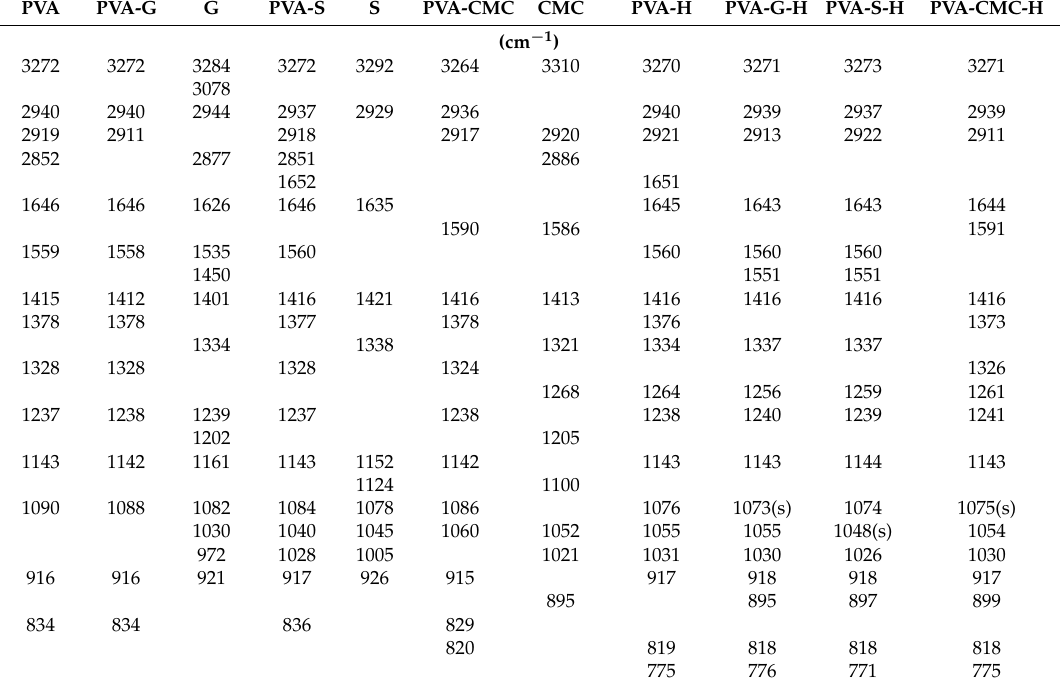
Table 4. Samples FTIR bands, where “G” is gelatin, “S” is starch, “CMC” is sodium carboxymethyl cellulose, and “H” is manuka